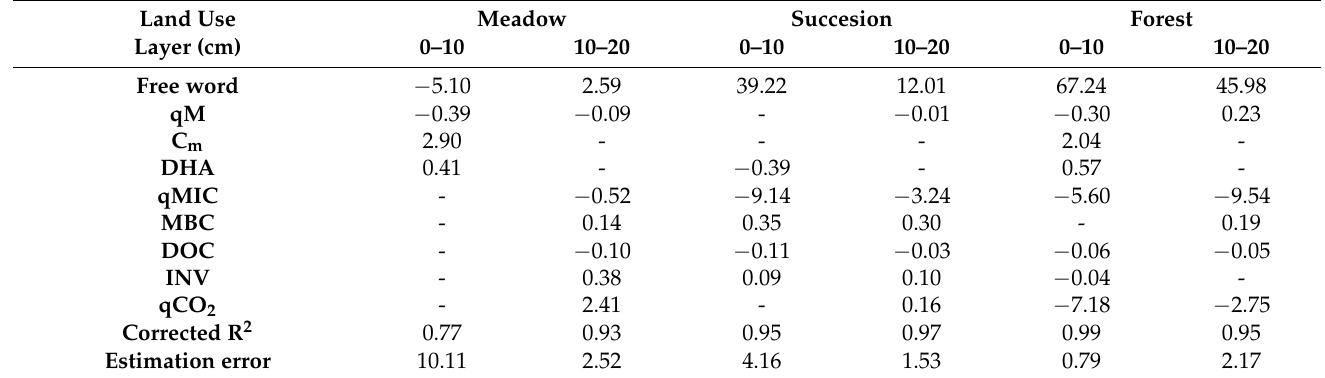
Table 4. Total organic carbon (C org ) dependent variable regression for individual examined land-use and soil layer